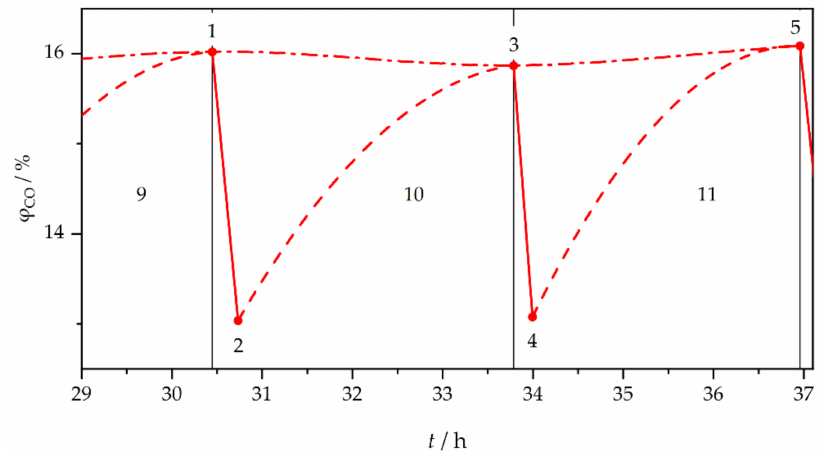
Figure 5. Cutout of the trend of the gas-phase volume fraction of CO for the intervals 9, 10, and 11. The points 1, 3, and 5 show the measured volume fraction at the end of the intervals 9, 10, and 11, respectively. The points 2 and 4 represent the calculated volume fraction at the beginning of interval 10 and 11, respectively. The estimated trend of the volume fraction within one interval is depicted by the dashed line. The ‘dot-dash’ line forming the connection of points 1, 3, and 5 represents the measured gas-phase volume fraction of CO.